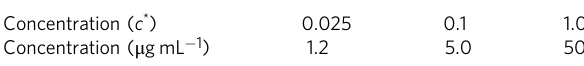
Table 1 Concentration of λ -DNA solutions used in this work Concentration ( c *